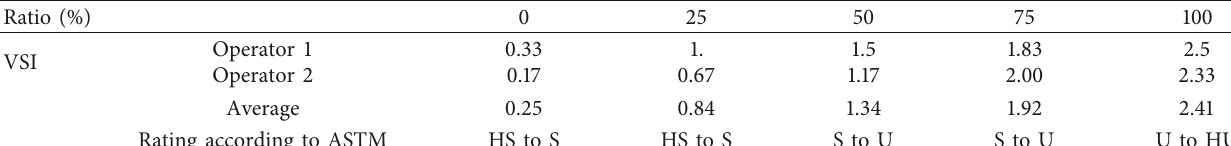
Table 5: VSI of the various mixes.